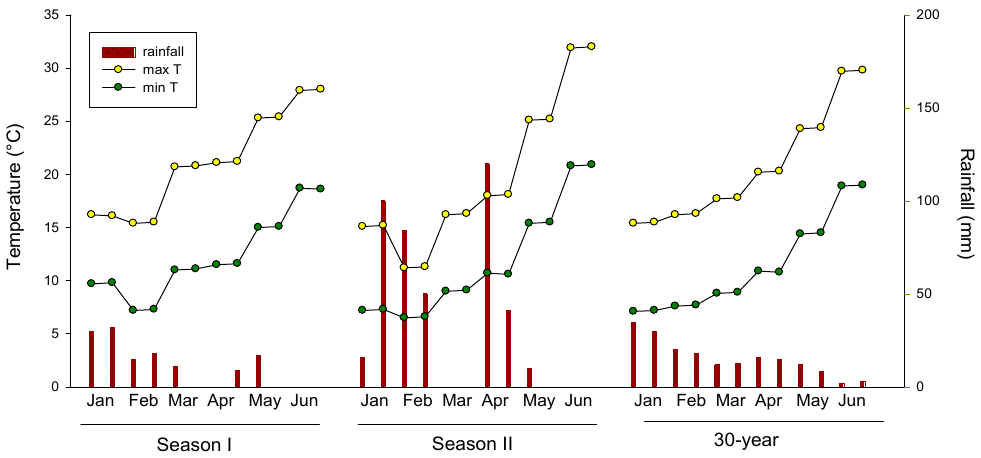
Figure 1. Average fifteen-day trend of maximum and minimum air temperatures and the fifteen- day total rainfall during the trial throughout Season I and Season II, and 30-year (1977–2006) climatic trend.